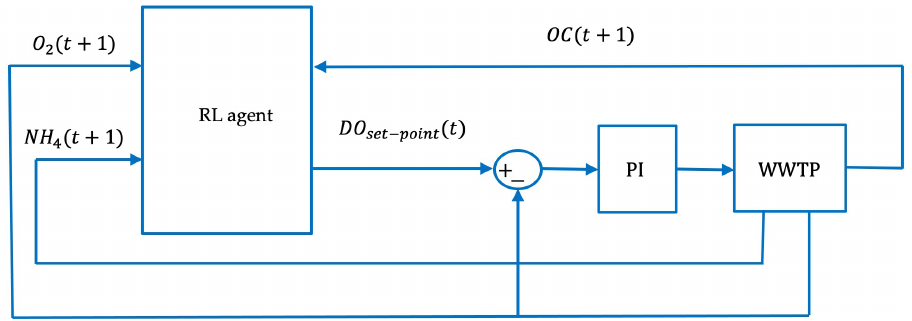
Figure 7. Control loop using the RL agent. Reprinted/adapted with permission from Ref.